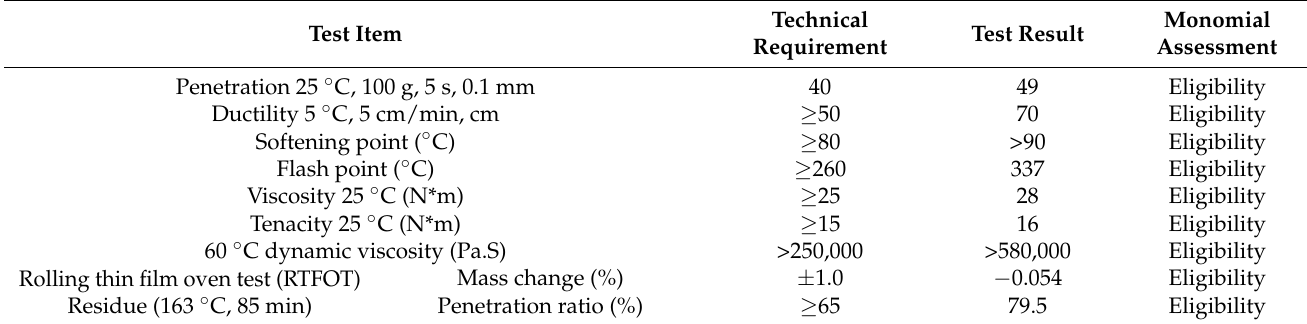
Table 3. The technical index of high-viscosity modified asphalt.